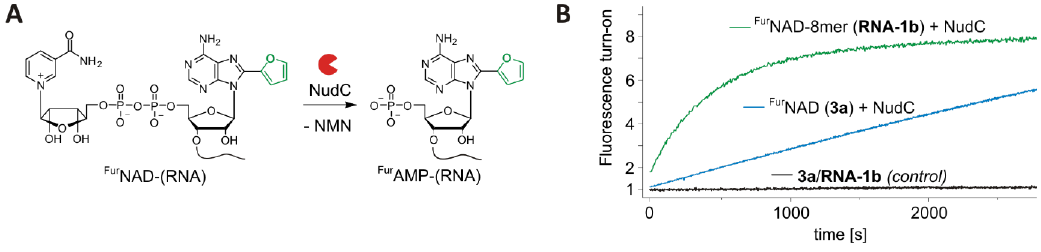
Figure 4. Application of Fur NAD-(RNA) as fluorescent turn-on probes. ( A ) Enzymatic decapping of Fur NAD-(RNA) by NudC. ( B ) Enzyme kinetics of NudC in the absence (control) and the presence of Fur NAD (4.5 µM) or Fur NAD-RNA (4.5 µM). NudC shows highest activity on RNA as substrate.